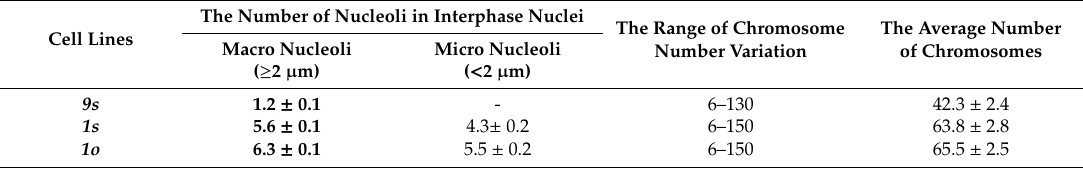
Figure 2. Cytogenetic variations in the Panax ginseng cell cultures. ( A ) Histology of the cell cultures (hematoxylin / alcian blue stained), arrows indicate the nucleoli. ( B ) The DAPI stained nuclei and ( C ) chromosomes. Table 1. Statistics on mixoploidy in cell populations and the structure of interphase nuclei in the Panax ginseng cell